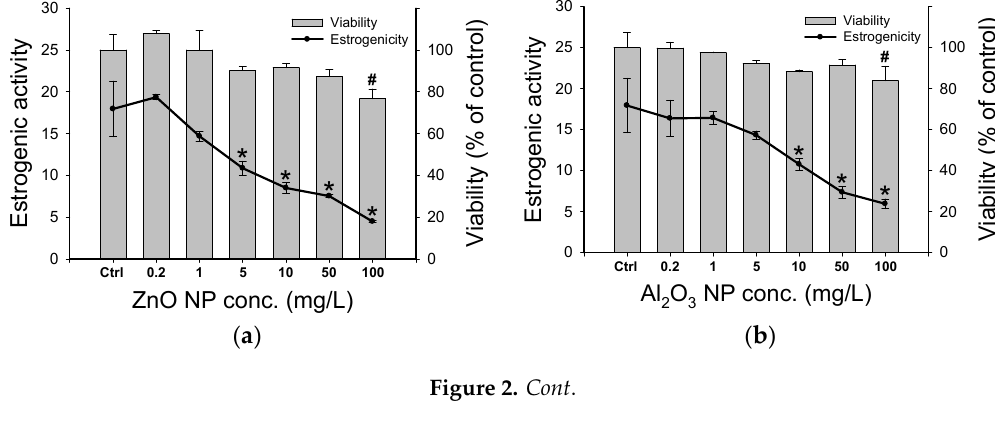
Values in table represent mean ± standard deviation.